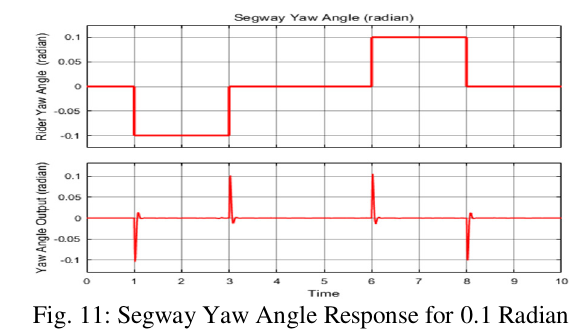
Fig. 11: Segway Yaw Angle Response for 0.1 Radian